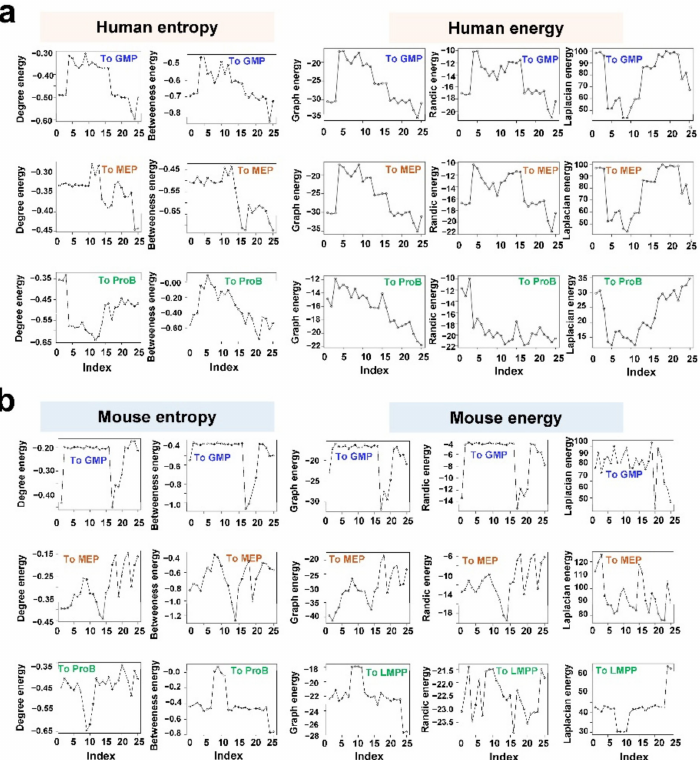
Figure 5. Lower entropy and energy than random networks. Network Entropy and energy of time- varying networks of human ( a ) or mouse ( b ). Random networks with the same nodes and edges were generated, and their entropy and energy were used as references. The Y axis shows normalized values against those of random